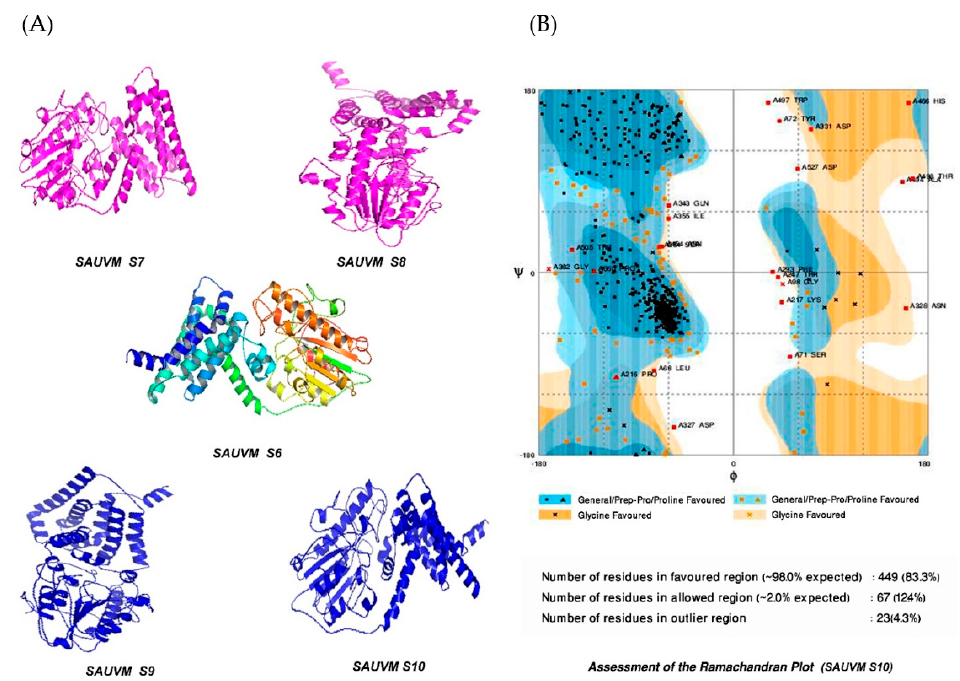
Figure 5. Modelled structures of Salmonella SAUVM MCR-1 proteins and validation. ( A ) Three dimensional (3D) modeling of Salmonella SAUVM MCR-1 proteins (SAUVM S6 to SAUVM S10) were performed using I-TASSER, which functions by identifying structure templates from the PDB library. The confidence of each model was quantitatively measured by C-score. From these models of MCR-1 proteins, the Salmonella SAUVM S10 model was randomly selected, ( B ) analyzed and structurally validated with the Ramachandran plot assessment server (RAMPAGE).